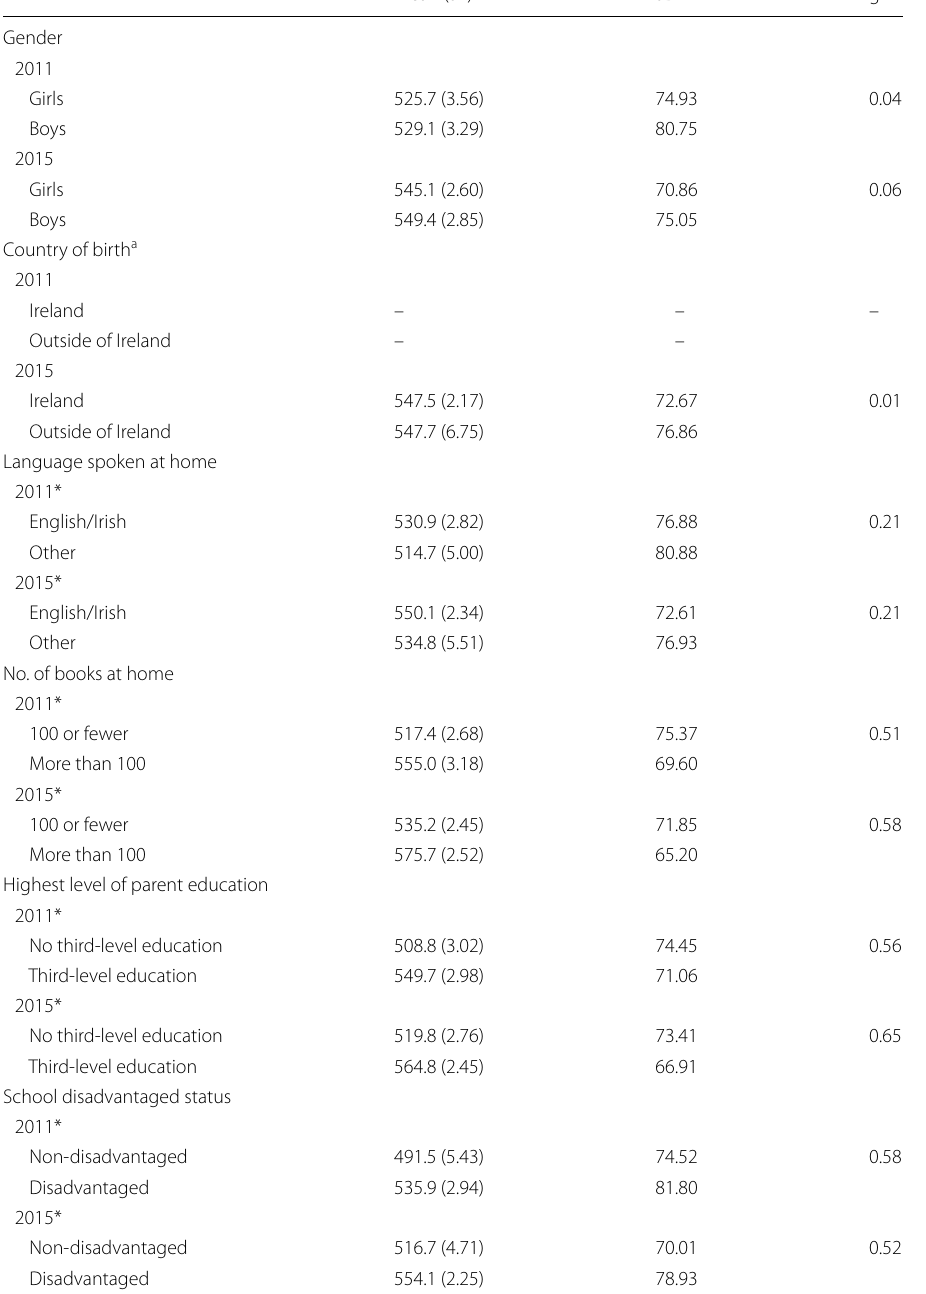
Table 5 Differences in mathematics performance between TIMSS 2011 and 2015 for selected groups of